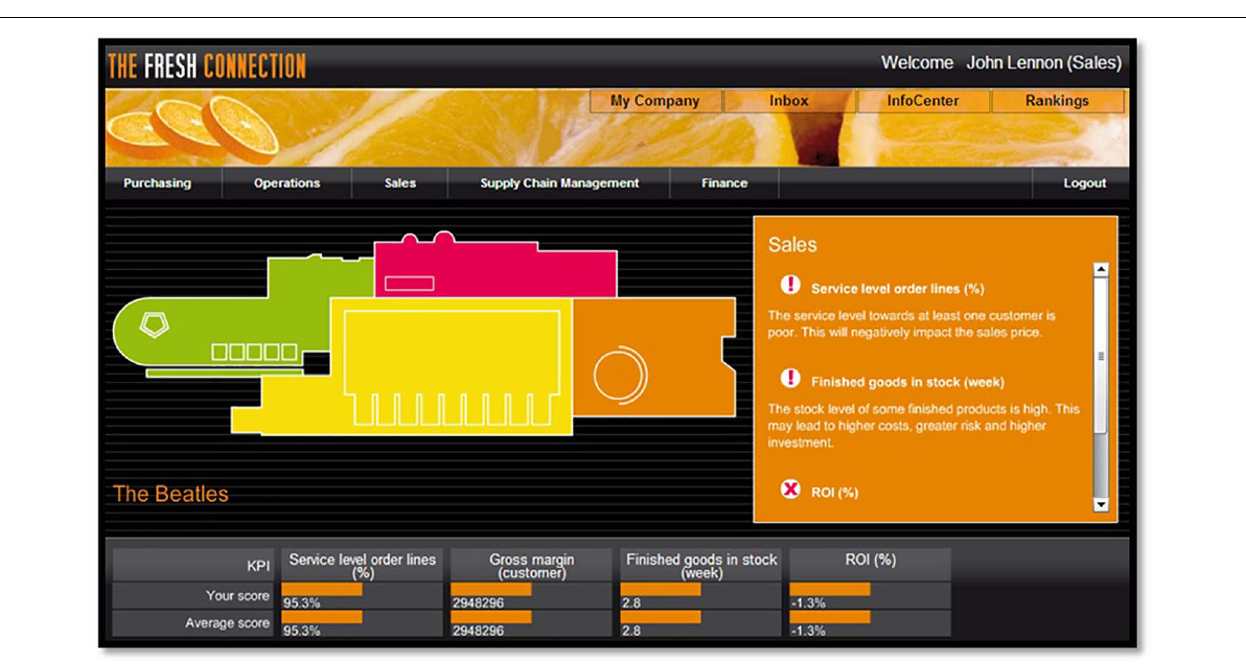
FIGURE 2 | Screenshot of “Fresh Connection” business